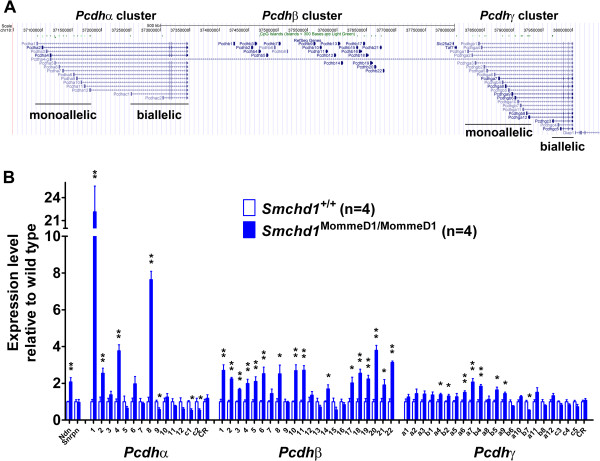
The clustered protocadherin genes show altered expression levels in Smchd1 mutants. (A) The clustered protocadherin genes (Pcdhα, Pcdhβ, and Pcdhγ) lie in a cluster on mouse Chr:18 and are expressed in a unique manner. Transcripts from the Pcdhα and Pcdhγ genes show alternative first exons that are monoallelically expressed in a random combinatorial manner and spliced to downstream exons that are biallelically expressed. The Pcdhβ genes exist as individual genes. (B) The expression levels of the protocadherin genes (Pcdhα, Pcdhβ, and Pcdhγ) were quantified by qRT-PCR using RNA derived from whole adult male mouse brains. The synthesis of first-strand cDNA was primed with a cocktail of the reverse primers used for qRT-PCR. In each case, the qRT-PCR signal was normalized relative to that of Rala and plotted relative to the corresponding Smchd1+/+ sample. Statistical analysis was performed using the t test. ** P < 0.01 and * P < 0.05 compared with wildtype. Error bars indicate standard error.